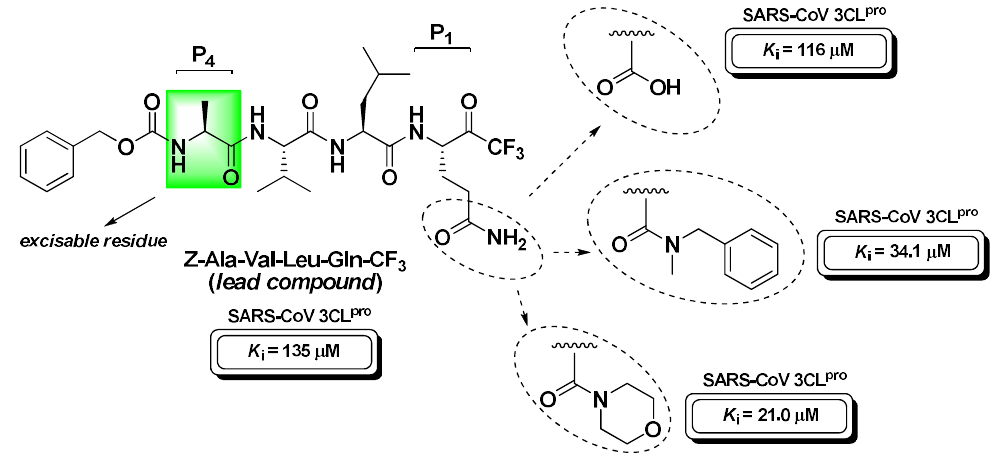
Figure 19. Chemical structure, SAR analysis, and activity against SARS-CoV 3CL pro of the most relevant t-PFMK developed by Bacha U. et al.